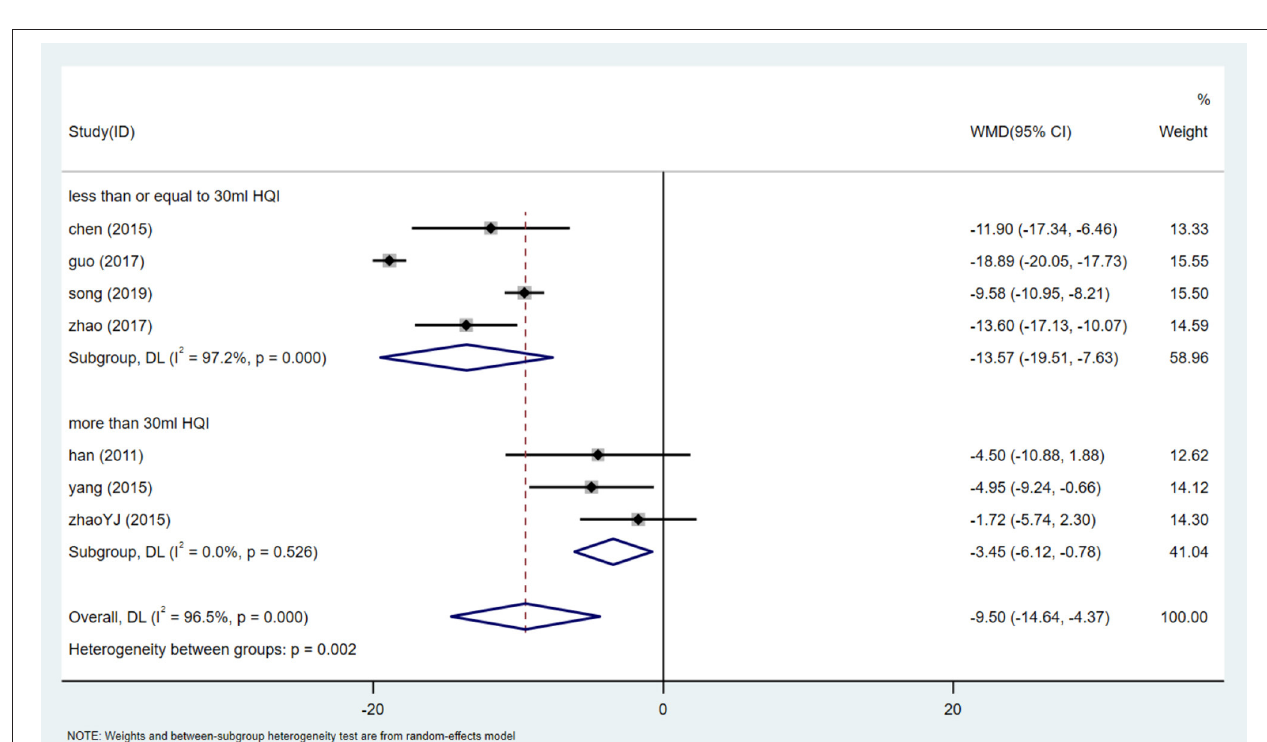
FIGURE 10 | Subgroups analysis of SBP.